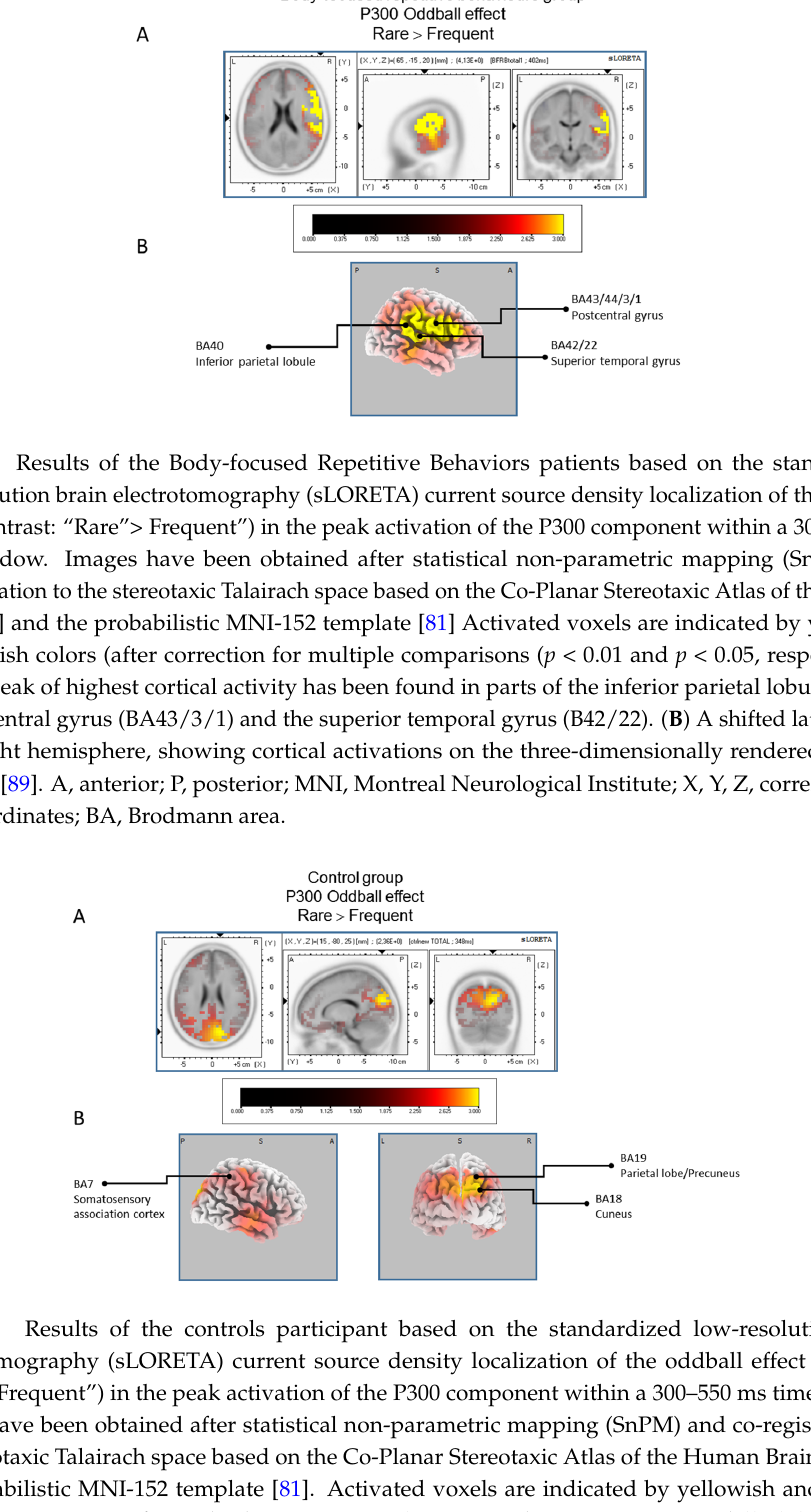
colors (after correction for multiple comparisons ( p < 0.01 and p < 0.05, respectively)). ( A ) The peak of highest cortical activity has been found in parts of the superior frontal gyrus (BA10), the medial frontal gyrus (BA6), the paracentral lobule (BA31), and the cingulate gyrus (BA24). ( B ) A shifted transverse and sagittal view of the left and the right hemisphere, showing cortical activations on the three- dimensionally rendered Colin27 template [89] L, left; R, right; A, anterior; P, posterior; MNI, Montreal Neurological Institute; X, Y, Z, corresponding MNI coordinates; BA, Brodmann Area.